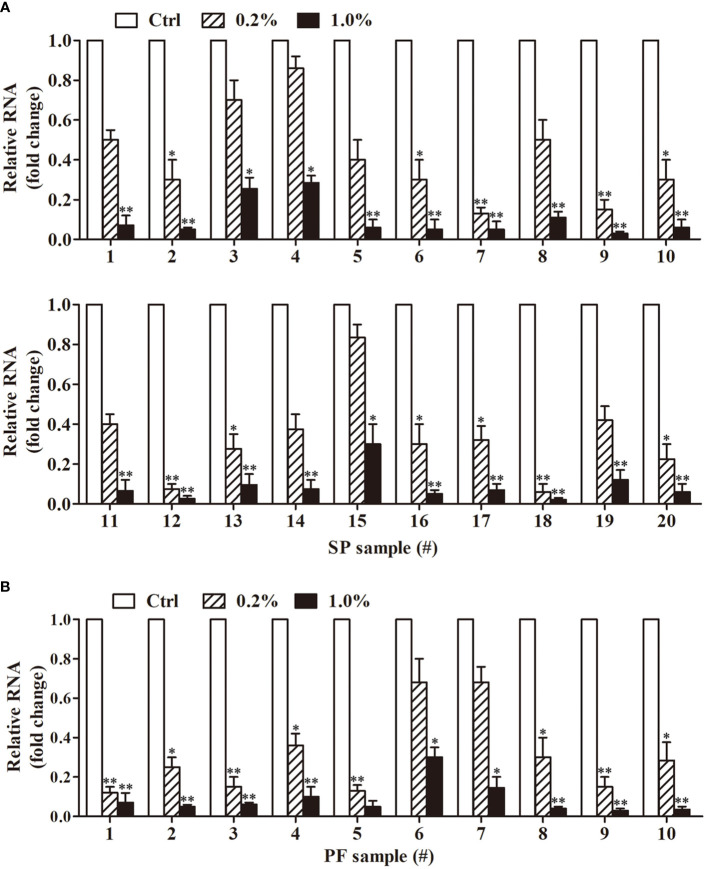
Antiviral effect of SP and PF from individual donors. (A) Antiviral effect of SP. SP samples were collected from 20 individual donors. MuV was incubated with 0.2 or 1.0% individual SP samples for 2 h. MuV without treatment served as the control (Ctrl). HeLa cells were infected with 1.0 MOI of MuV. Total RNA was extracted from cells 48 h after MuV infection. MuV-NP RNA levels were determined using real-time qRT-PCR. (B) Antiviral effect of individual PF samples. Individual PF samples were collected from 10 donors. MuV was incubated with individual PF, and HeLa cells were infected as described in (A). MuV-NP RNA levels were determined 48 h after infection. Data are presented as means ± SEM of three experiments. *P < 0.05, **P < 0.01.